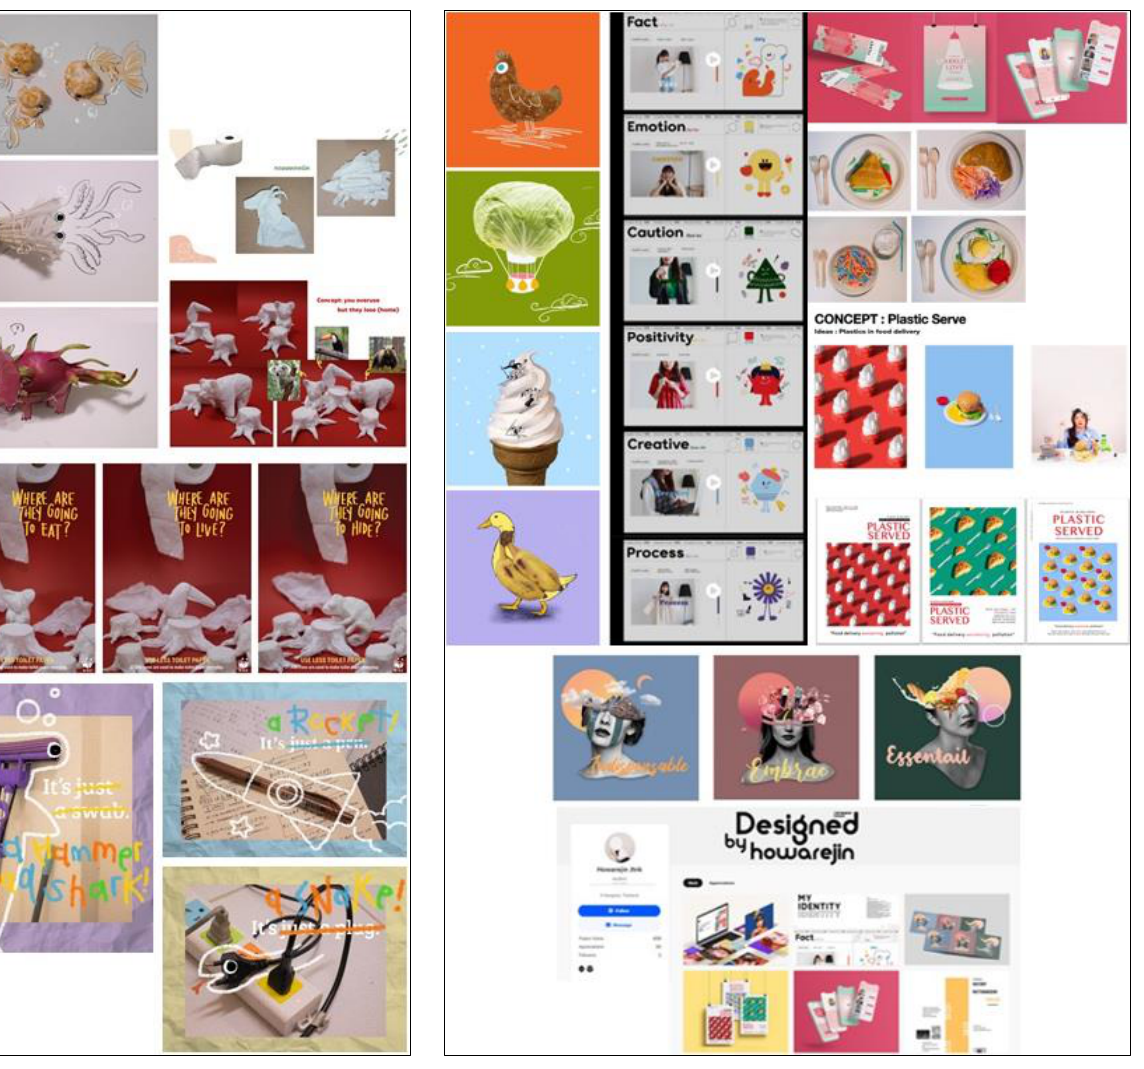
Figure 3. Examples of some creative works of student of the strong group